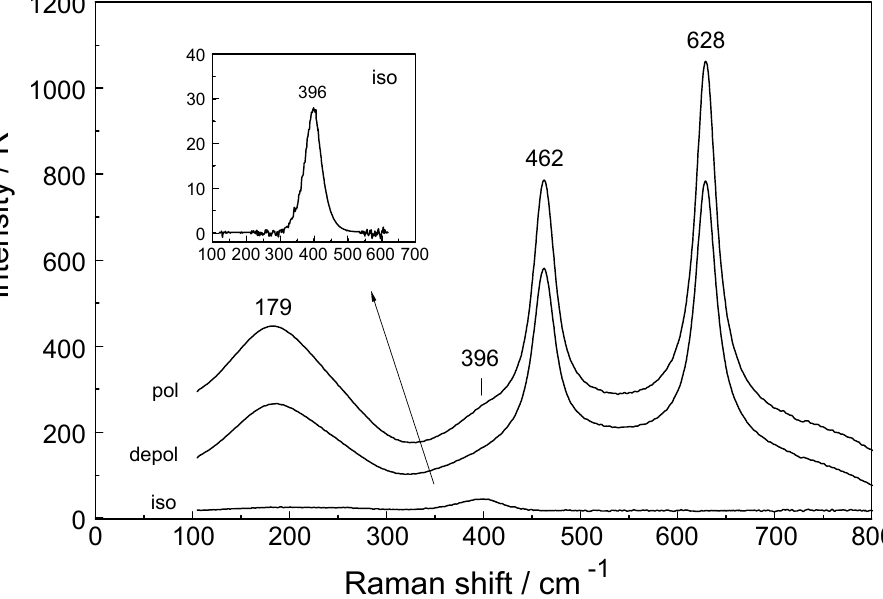
Figure 2. Raman spectrum in R-format (polarized, depolarized and isotropic scattering) of a 0.186 mol · L − 1 Lu(ClO 4 ) 3 solution (R w = 289.0). The isotropic band at 396 cm − 1 is the symmetric stretching mode of the LuO 8 skeleton of [Lu(OH 2 ) 8 ] 3+ . The ClO 4 − (aq) deformation bands at 462 and 628 cm − 1 are depolarized and do therefore not appear in the isotropic scattering. The broad band at 179 cm − 1 is the restricted translation mode of water.